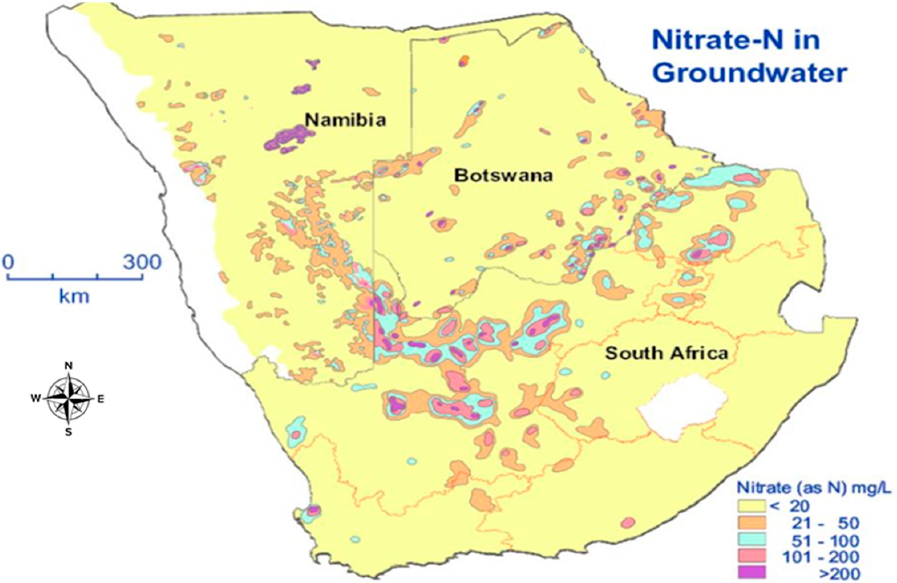
Figure 2. Map of Southern Africa showing sampling points where more than 10 mg/L of nitrates were detected in groundwater (Used with requested permission from [46]).